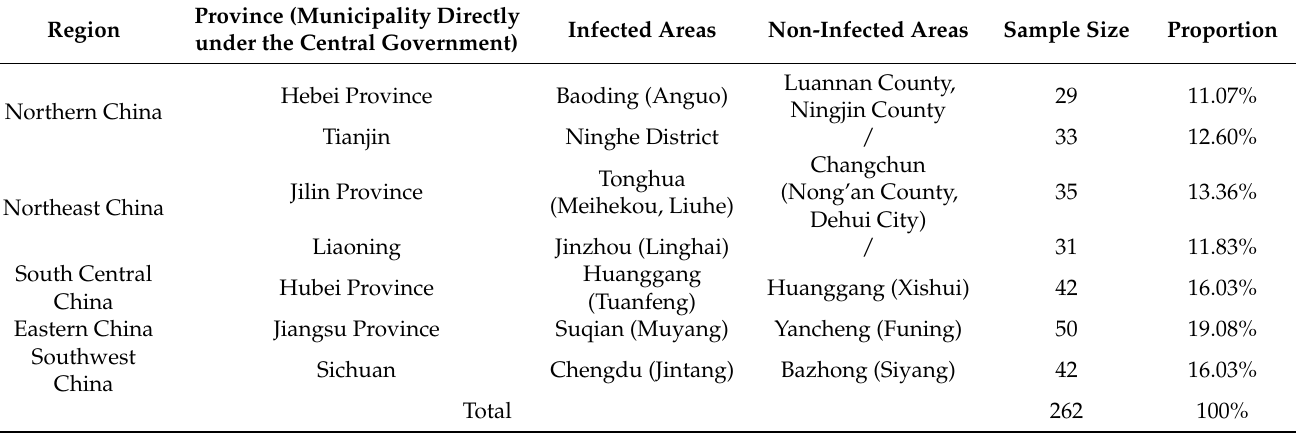
Table 2. Regional distribution of the survey